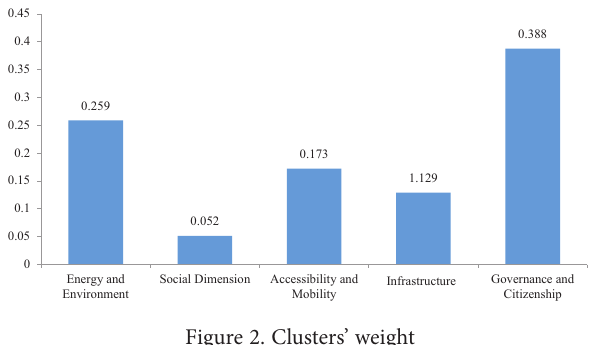
Figure 2. Clusters’ weight Table 3. Criteria selected for analysis